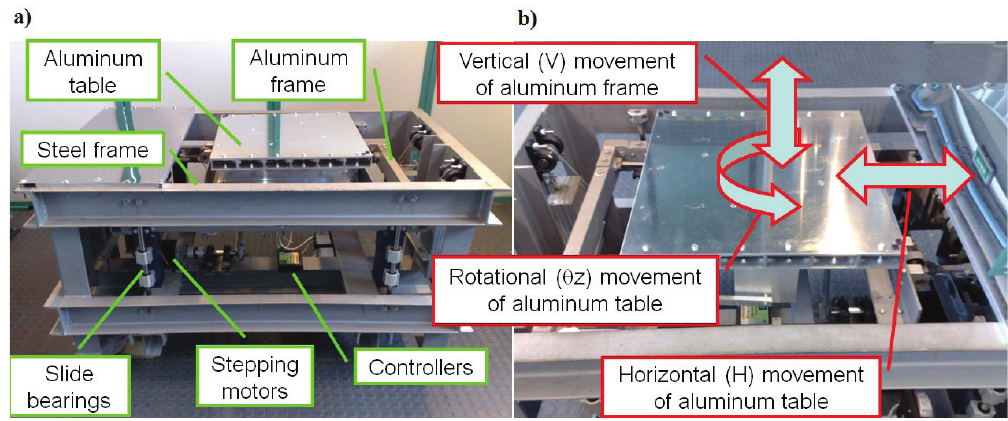
Figure 2: The shake table: (a) main elements and (b) possible directions of kinematic